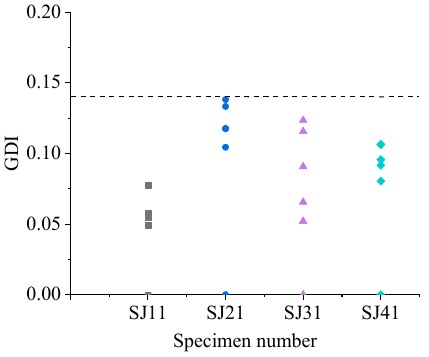
Figure 10. Grouted defect index (GDI) of specimens without grouted defect.